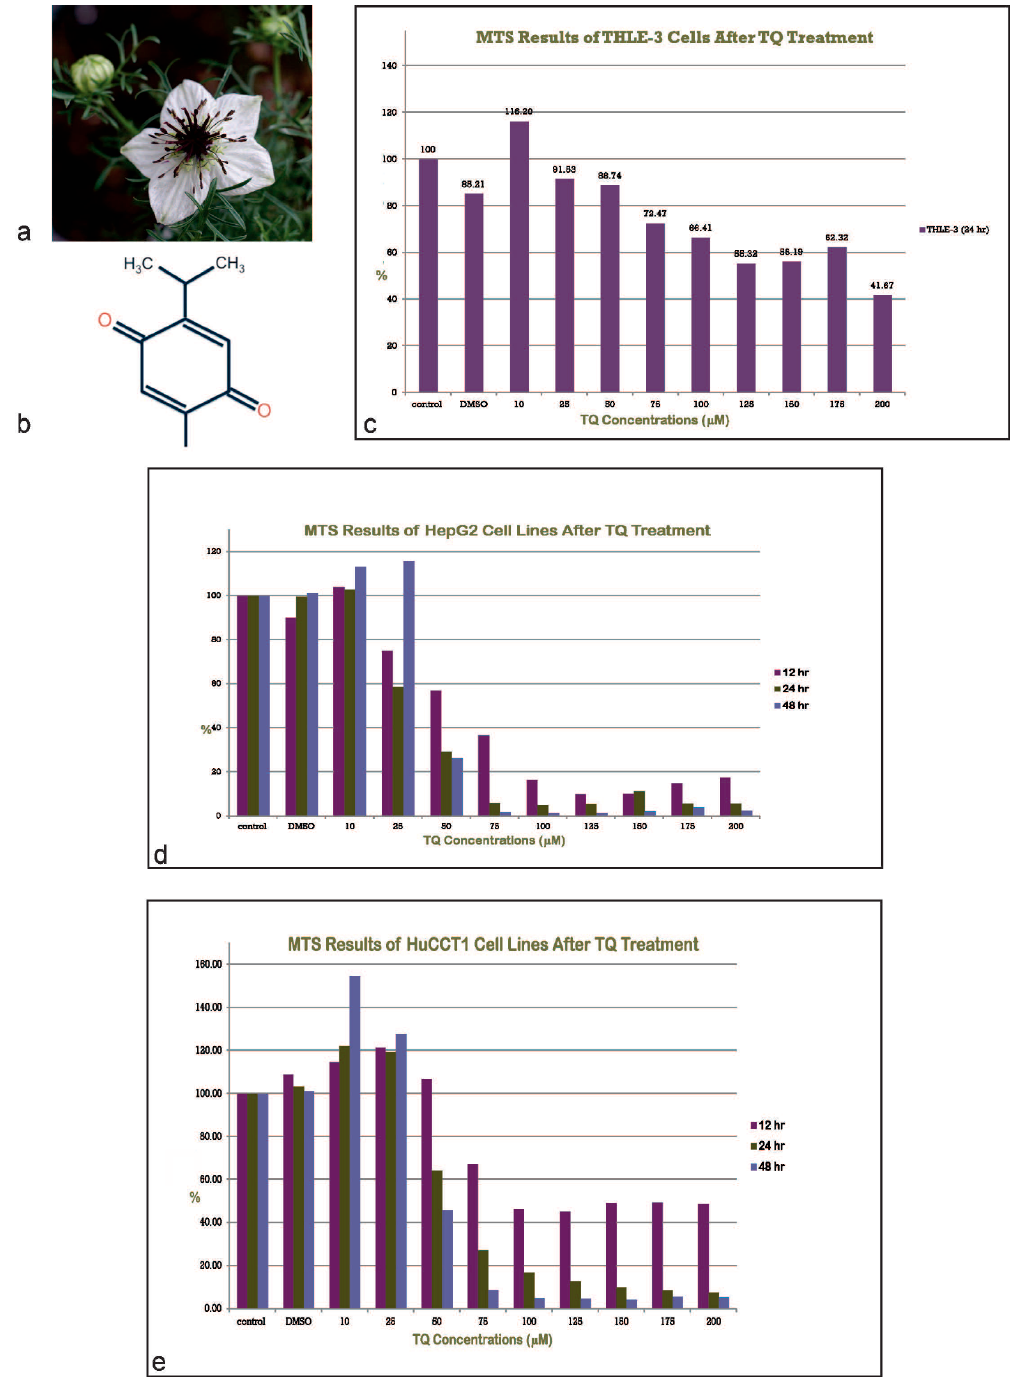
Figure 1. ( a ) Nigella sativa flowering plant. ( b ) Chemical structure of thymoquinone. ( c ) Anti- proliferative effect of TQ on THLE-3 cell lines. There is minimal anti-proliferation using methoxyphenyl-2-(4-sulfophenyl)-2H-tetrazolium (MTS). ( d ) Anti-proliferative effect of TQ on HepG2 cell lines. There is evidence of an anti-proliferative effect of TQ as measured using the methoxyphenyl- 2-(4-sulfophenyl)-2H-tetrazolium (MTS assay), which resulted in dose- and time-dependent growth inhibition in the cell line. ( e ) Anti-proliferative effect of TQ on HuCCT1 cell lines. There is evidence of an anti-proliferative effect of TQ as measured using the methoxyphenyl-2-(4-sulfophenyl)-2H- tetrazolium (MTS) assay, which resulted in dose- and time-dependent growth inhibition in the cell line (h, hr: